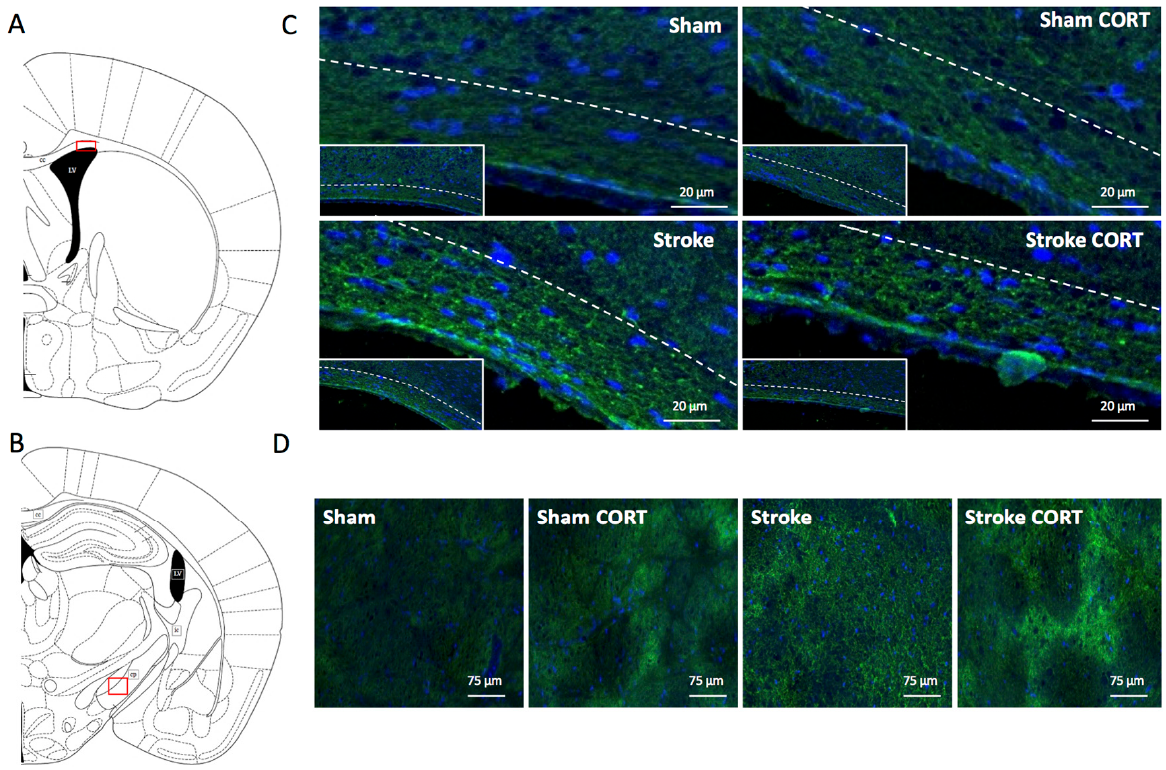
Figure 5. Corticosterone (CORT) and stroke induce axonal degeneration labelled by Fluoro-Jade C. The left panels show schematic representations of the approximate regions of the ( A ) corpus callosum (CC) and ( C ) corticospinal tract (CST) where pictures were taken. Panel ( B ) shows Fluoro-Jade C staining in the CC region across four groups: sham, sham + CORT, stroke, stroke + CORT. Small rectangles show the total area of CC and the big rectangles are a magnification of these areas. Scale Bar = 20 µm. Panel ( D ) shows representative pictures taken in the area of CST across all 4 groups. Scale Bar = 75 µm.